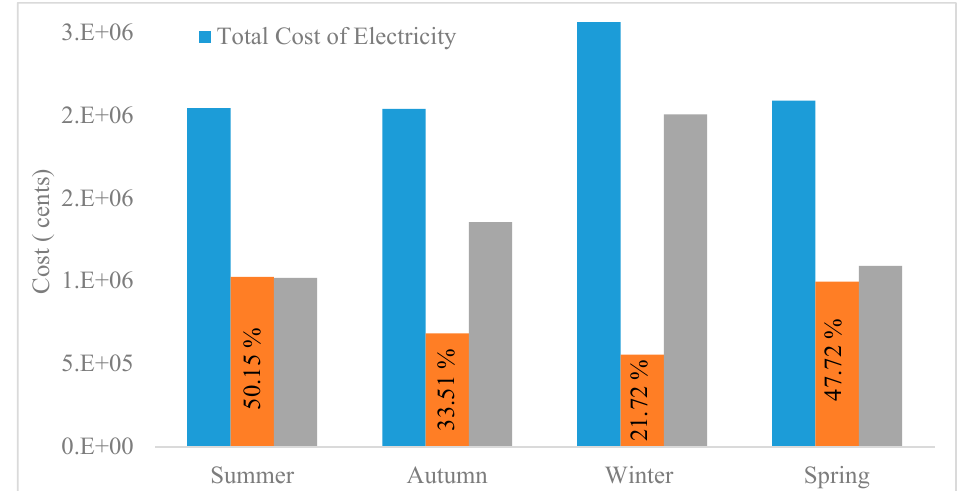
Figure 22. Seasonal cost savings provided by DERs.